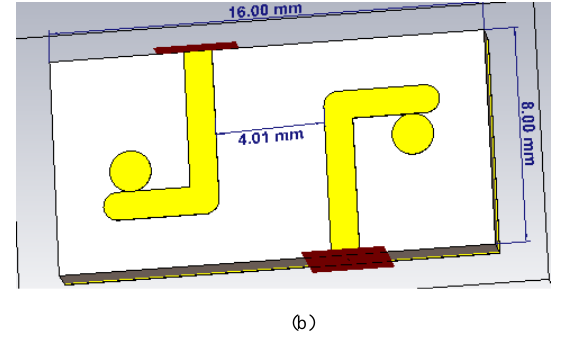
Fig5. The proposed MIMO 1X2 antenna, (a) of the first MIMO antenna model, and (b) the second MIMO antenna model.